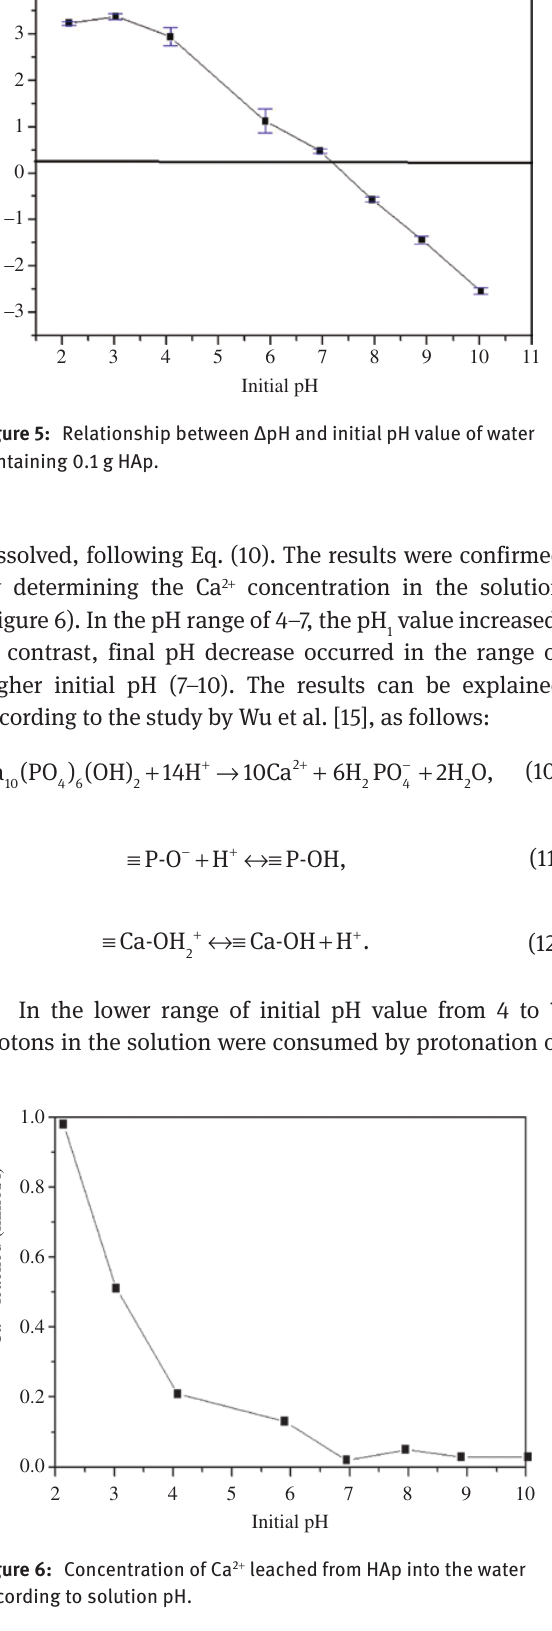
Figure 6: Concentration of Ca 2 + leached from HAp into the water according to solution